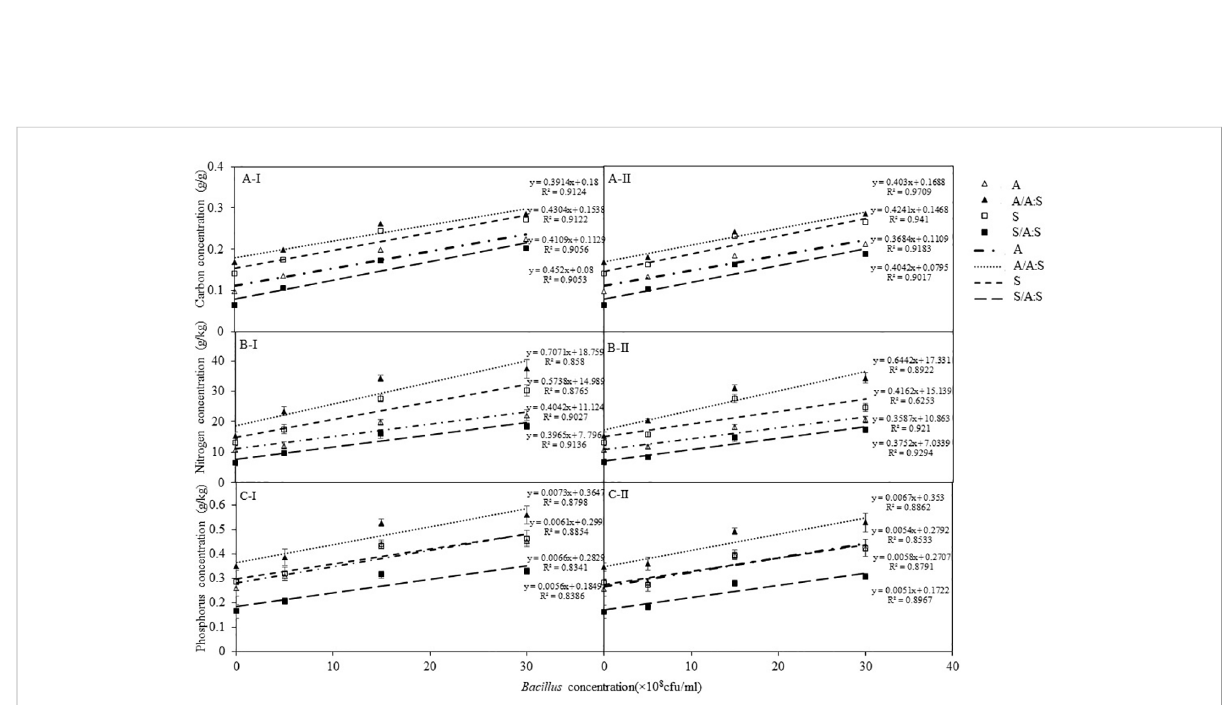
FIGURE 5 Effects of different concentration of B megaterium from the rhizosphere soil of A artemisiifolia (I) or of S. viridis (II) on carbon (A) , nitrogen (B) and phosphorus (C) levels. of Control; 0; C1: 5X10 8 cfu/mL of B. megaterium ; C2: 15X10 8 cfu/mL of B. megaterium ; C3: 30 X 10 8 cfu/mL of B. megaterium .